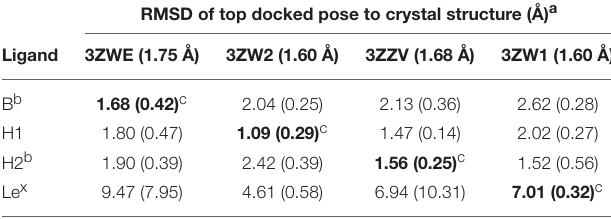
TABLE 1 | Top scoring docked pose characterization for BambL-blood group saccharide complexes. RMSD of top docked pose to crystal structure (Å) a